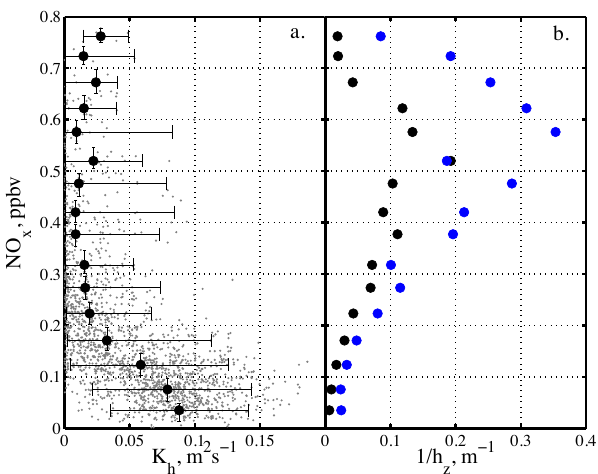
Fig. 6. (a) Atmospheric mixing ratios of NO x as a function of the turbulent diffusion coefficient of heat K h (both at 1m). Plotted are 10-min means (grey symbols) and data binned into 50pptv intervals (median values as black symbols and error bars indicating the 5–95 percentile range). (b) Binned NO x mixing ratios as a function of boundary layer height h z estimated after Pollard et al. (1973) (blue symbols) and Zilitinkevitch et al. (2002) (black